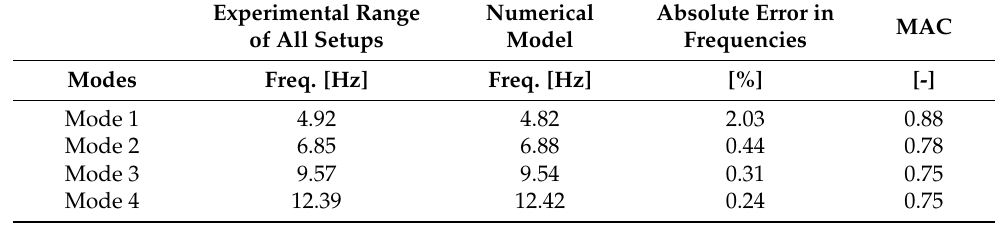
Table 1. Frequencies and MAC values of the four modes obtained through the dynamic identification campaign and numerical modal analysis.